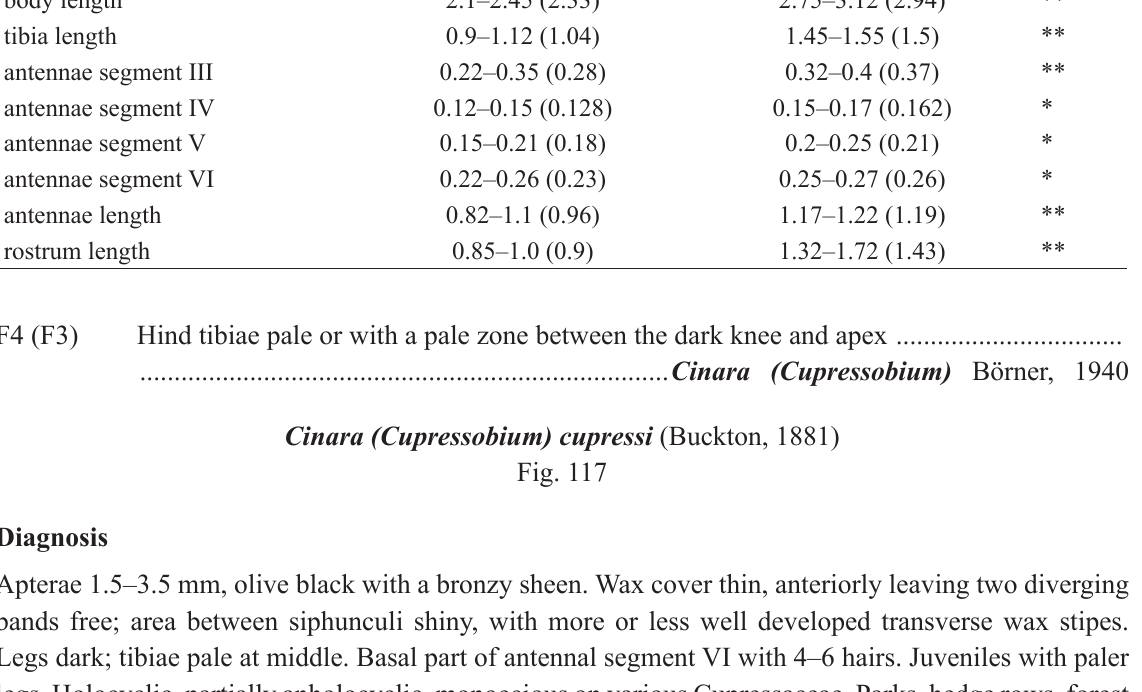
Table 1. Morphological features of the apterous viviparous females C. juniperi (n = 30) and C. mordvilkoi (n = 30). Minimum–maximum (mean). Statistical significance: * = P < 0.05; ** = P < 0.01. Length unit = mm. Data from Durak